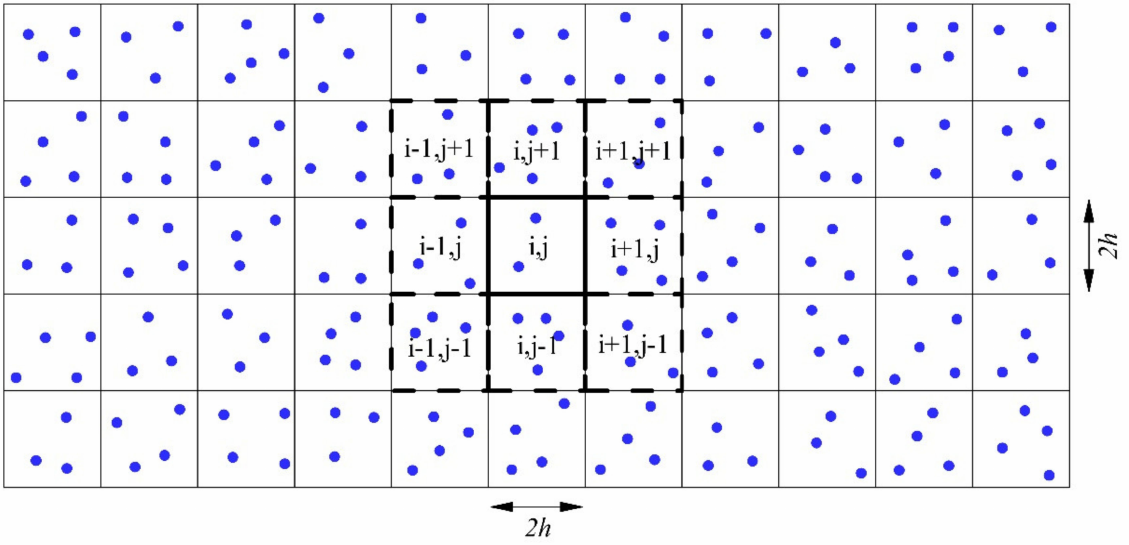
Figure 2. Sketch of the neighboring particles